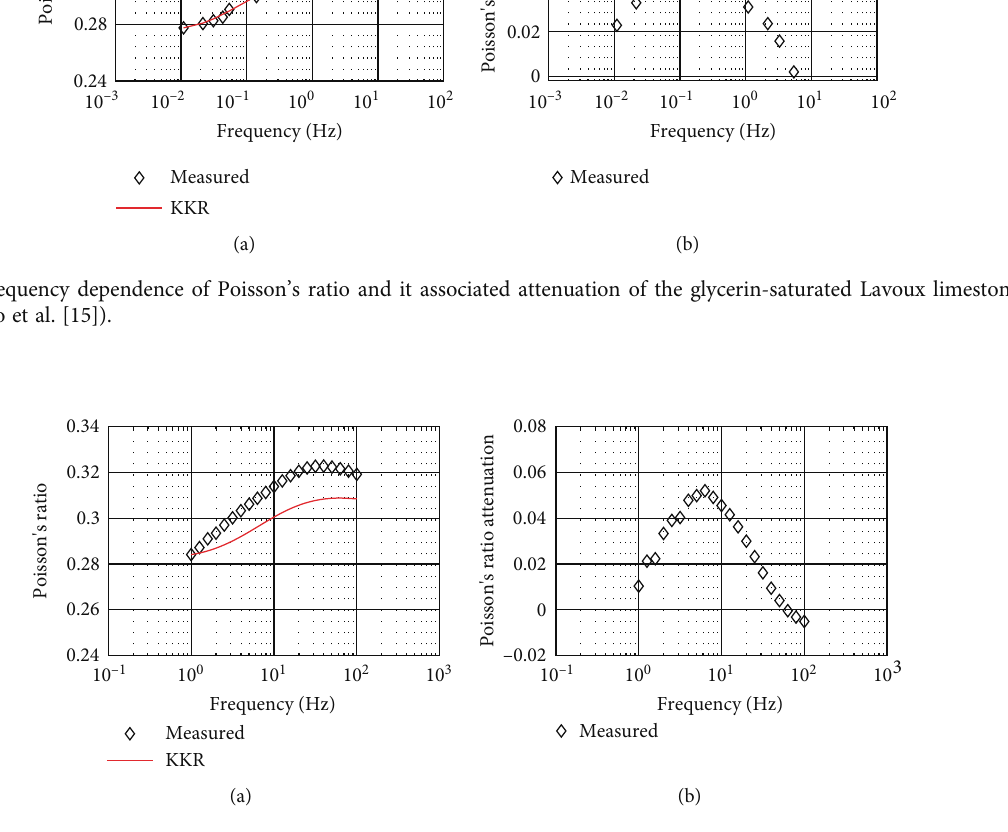
Figure 5: The frequency dependence of Poisson ’ s ratio and it associated attenuation of oil-saturated sandstone sample (from Sun et al.